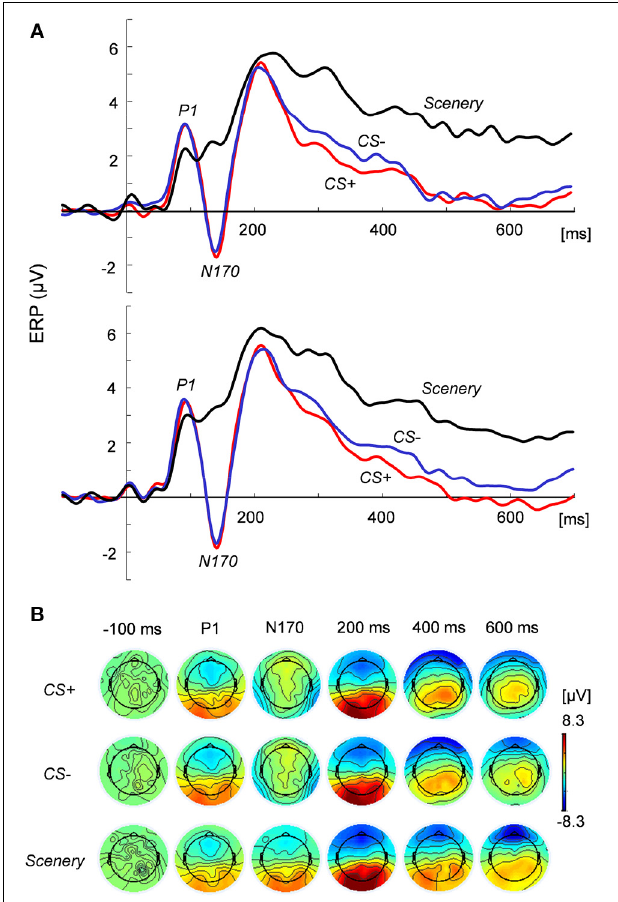
FIGURE 2 | ERP responses to and topography of the presented images. (A) ERP responses at the left ( top ) and right ( bottom ) posterior temporal regions under the CS + , CS − , and scenery conditions. (B) Two-dimensional topography of the presented images at P1, N170, and latencies of − 100 (pre-stimulus), 200, 400, and